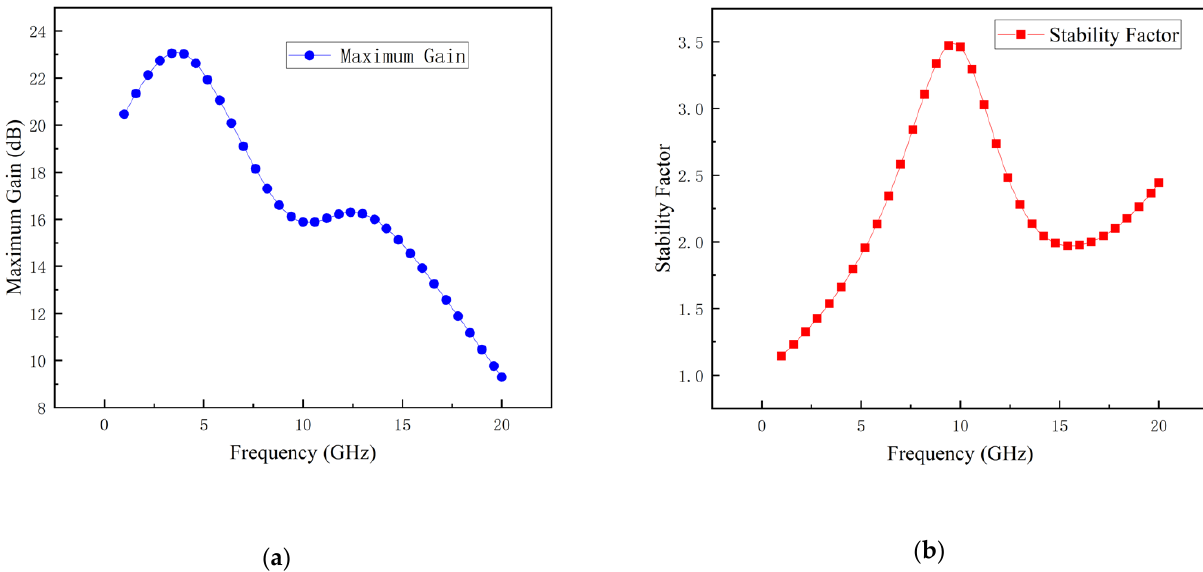
Figure 4. Simulated results of stability circuits: ( a ) maximum gain; ( b ) stability factor.